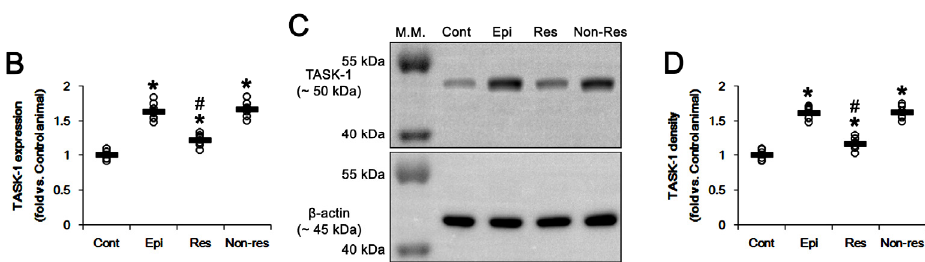
Figure 4. The effect of perampanel (PER) on TASK-1 expression in chronic epilepsy rats. Compared to control animals, TASK-1 expression is upregulated in CA1 astrocytes of epilepsy rats. PER significantly attenuates TASK-1 upregulation in responders, but not non-responders. ( A ) Representative photos of TASK-1 expression in the hippocampus (CA1, CA1 pyramidal cell layer; SR, stratum radiatum; SLM, stratum lacunosum-moleculare; ML, molecular layer of the dentate gyrus; DGL, dentate granule cell layer). ( B ) Quantitative analyses of the effect of PER on TASK-1 expression based on immunofluorescence data. Open circles indicate each individual value. Horizontal bars indicate the mean value. Error bars indicate SEM (*,# p < 0.05 vs. control and vehicle (Veh)-treated animals, respectively). ( C ) Representative images for Western blot of TASK-1 protein expression in the hippocampal tissues. ( D ) Quantifications of TASK-1 level based on Western blot (* , # p < 0.05 vs. control and vehicle (Veh)-treated animals).